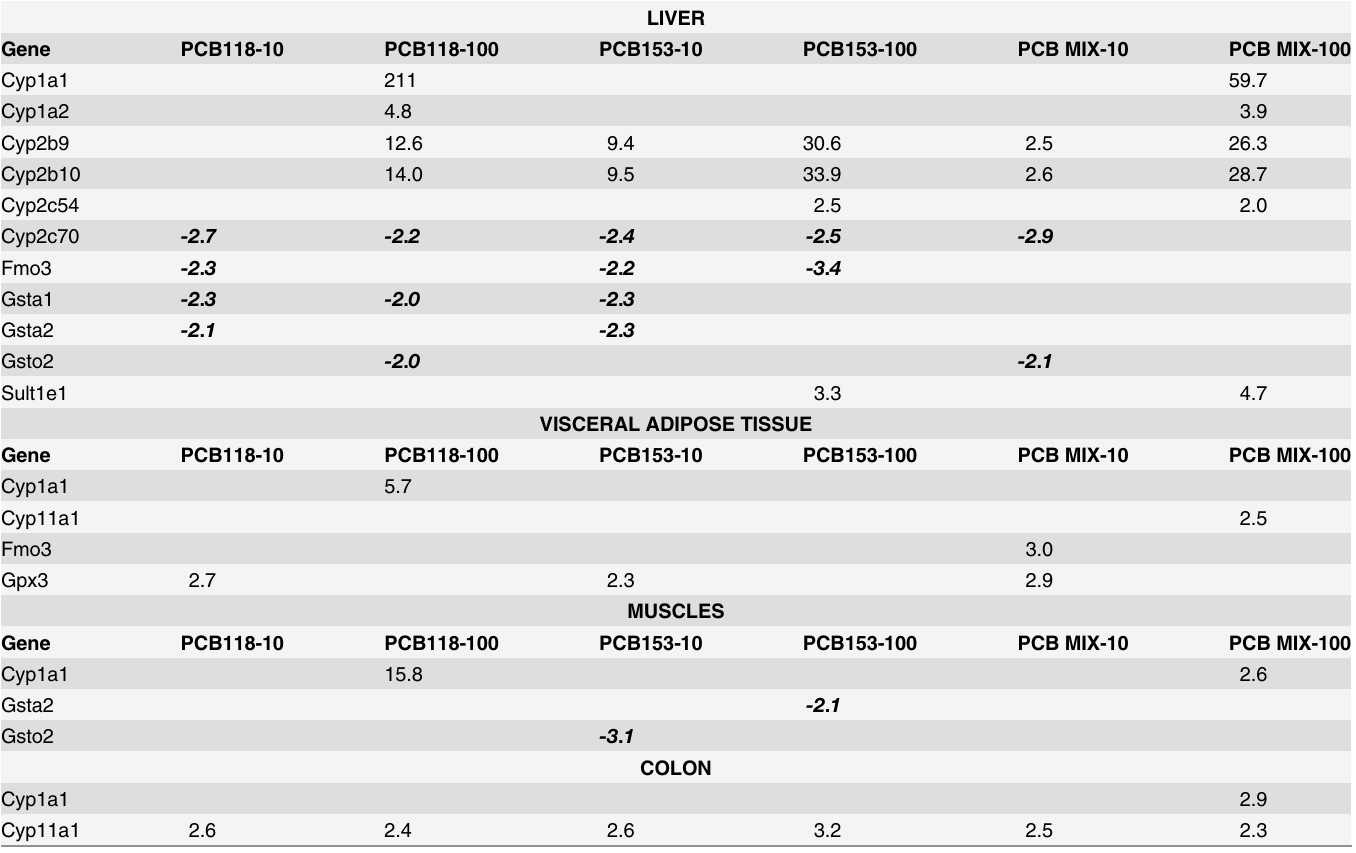
Table 4. Genes involved in the metabolism of xenobiotics based on microarray